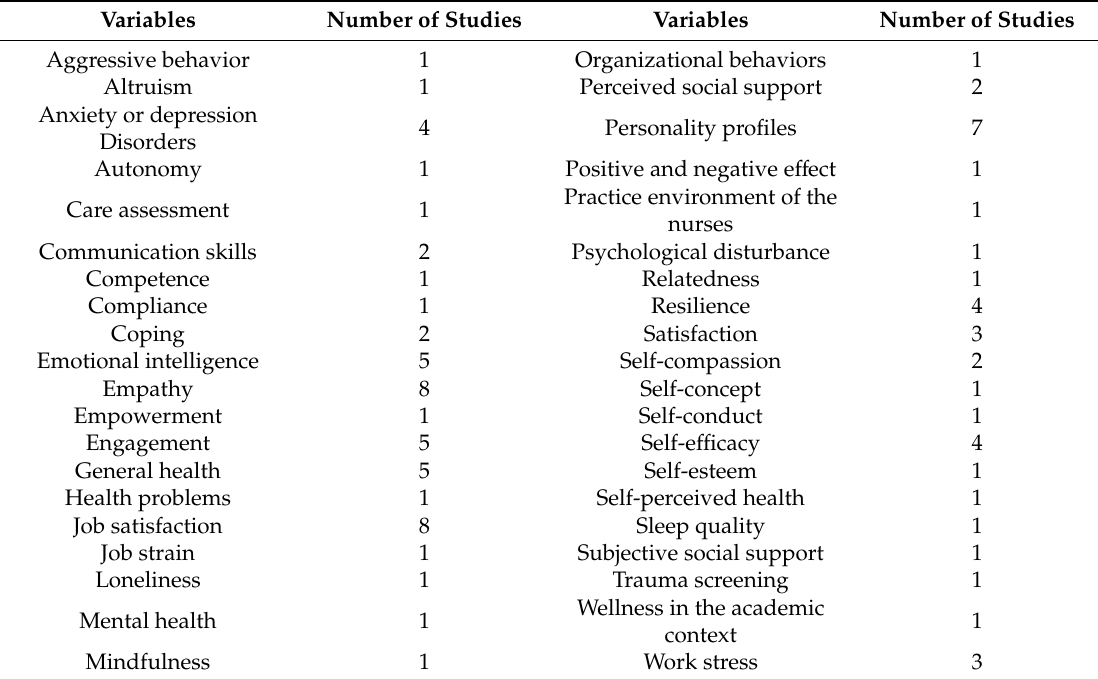
Table 5. Analysis by subject related to burnout in the